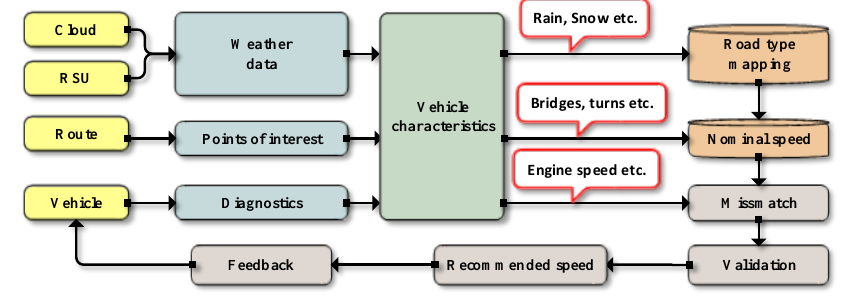
Figure 1. Overview of the proposed